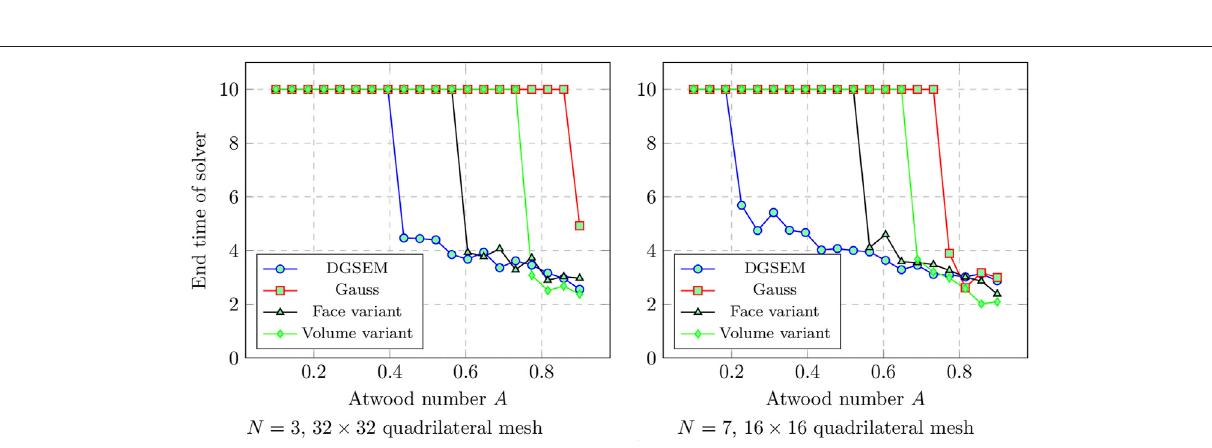
Frontiers in Physics |